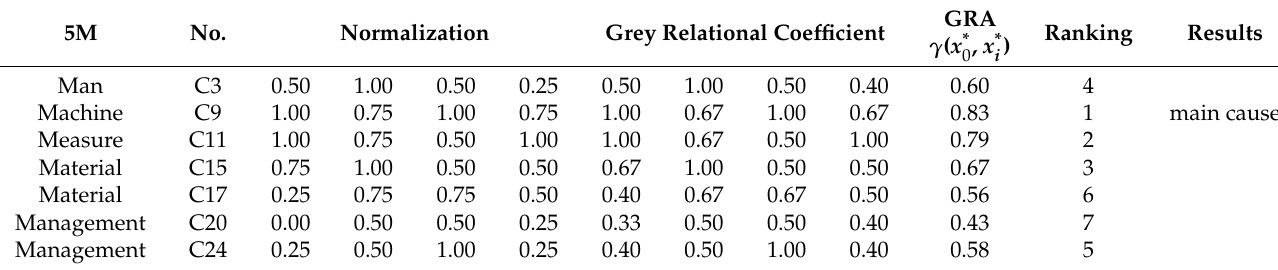
Table 4. Results from GRA to choose the main